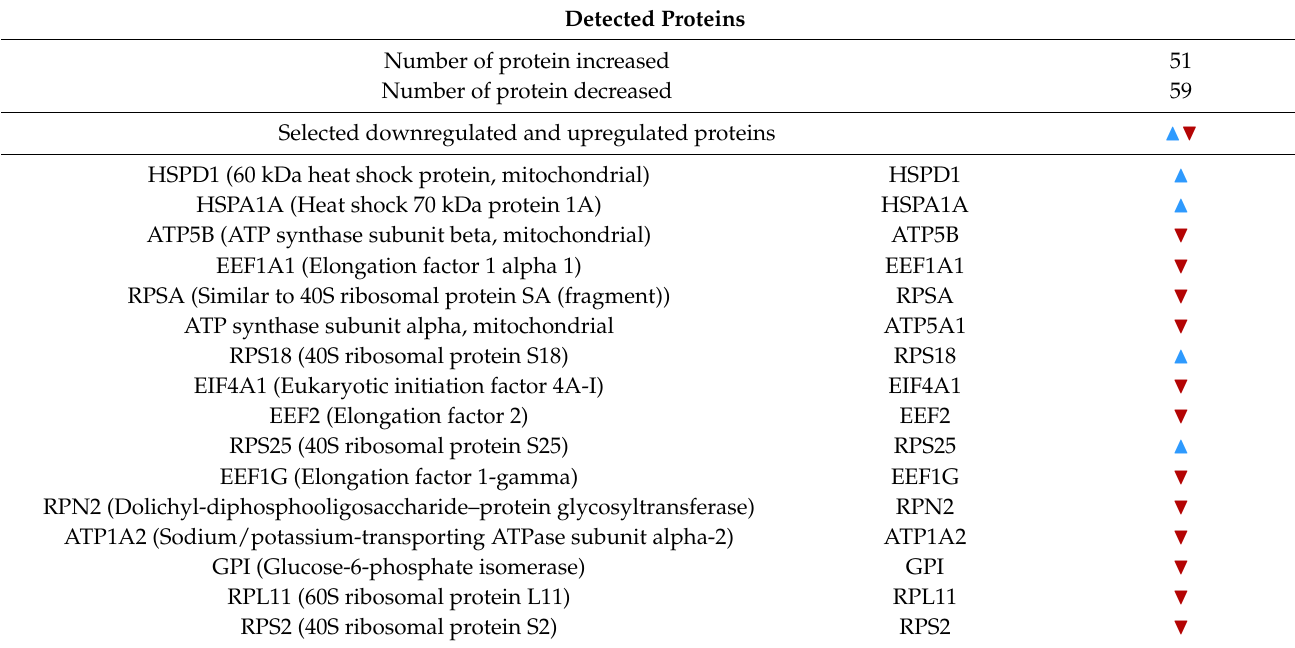
RPN2 (Dolichyl-diphosphooligosaccharide–protein glycosyltransferase)